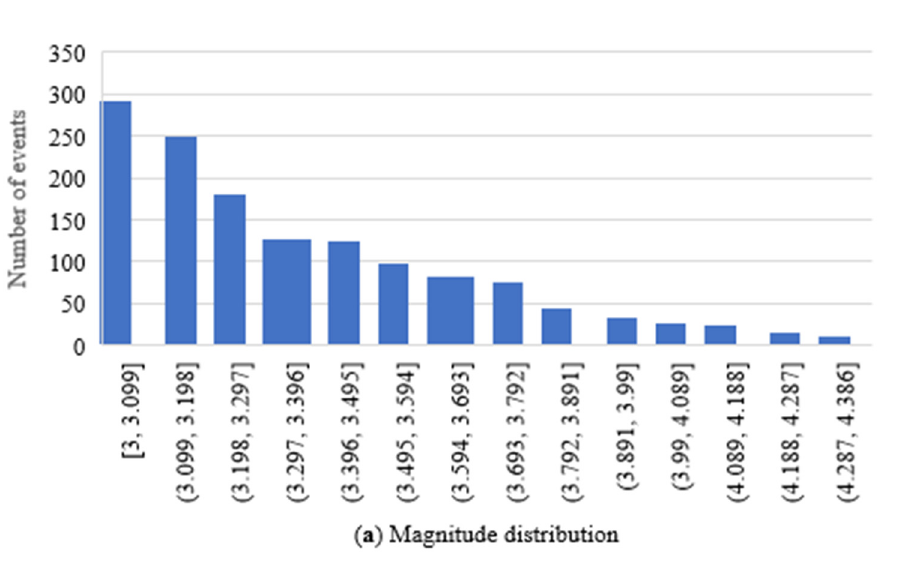
Figure 4. The histogram in ( a ) shows the magnitude distribution and the histogram in ( b ) shows the depth distribution of the events from the Southern California dataset used in experiments by the proposed model . 4.2. Experimentation All of the experiments are carried out on an Intel Core i7-7700 processor running at 3.60 GHz with 16 GB of RAM, an NVIDIA GeForce GTX 1080 graphics card, Windows 10, and TensorFlow 2.3 with CUDA toolkit, respectively. To optimize the network parameters, we started our model parameters as the param- eters of the model [18]. The experiments are designed to compare two different types of neural network models, GNN and BNGCNN, with the ultimate goal of developing a gen- eralized detection model as a result of the findings. A random 80/20 split is performed on the entire data set to create a training set and a validation set, respectively. Training set constitutes 80 percent of the whole data with 1140 out of 1427 events. This dataset is used for training the model. Remaining 20 percent data used as a validation set to validate the model performance with 287 out of 1427 events. We evaluate the performance of the trained model on both the training and validation data sets separately as [18]. Several models can be compared to one another with the use of an independent test set to deter- mine which is the most efficient. In addition, it should be emphasized that k-Fold cross-